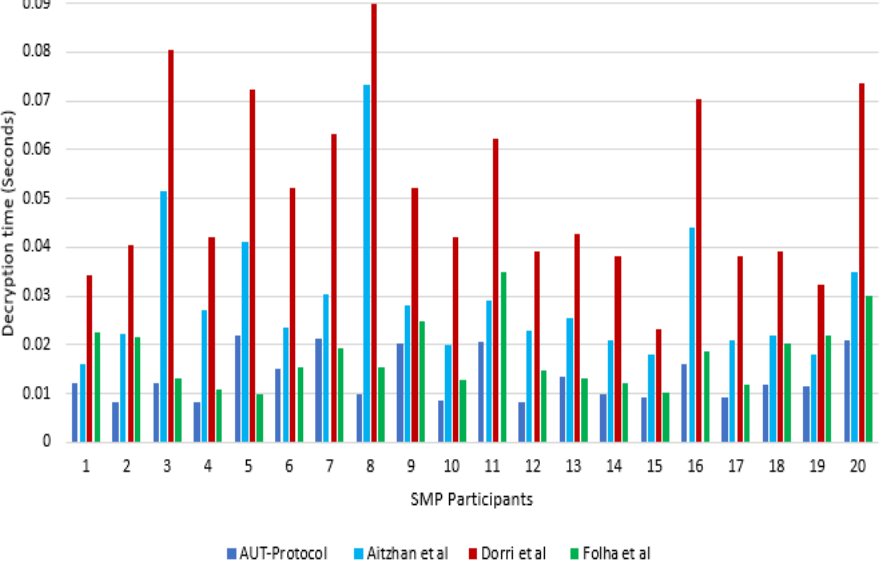
Figure 5. Comparison of the transactional message decryption